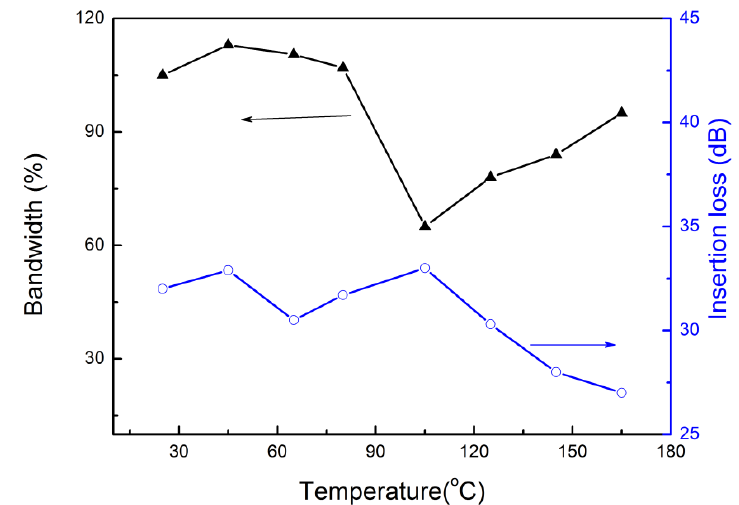
Figure 14. Temperature dependence of the bandwidth and insertion loss of the 1-3 composite single element ultrasonic transducer (with permission from